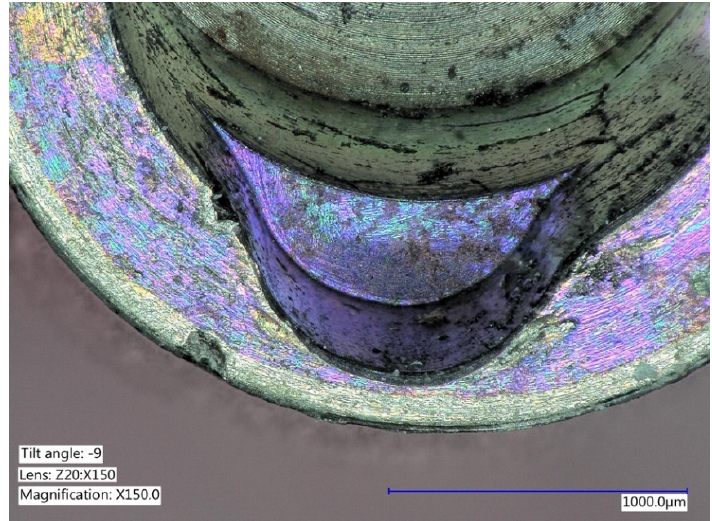
Figure 6. Explanted implant with a Trilobed connection. After disconnection of the implant crown, the evaluation of the implant connection shows severe wear, abrasion of the implant platform, and titanium particles.